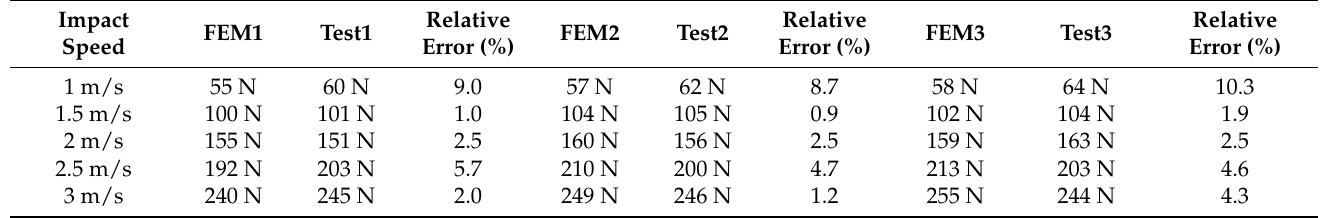
Table 5. Comparison of impact force obtained via numerical simulation and experimental